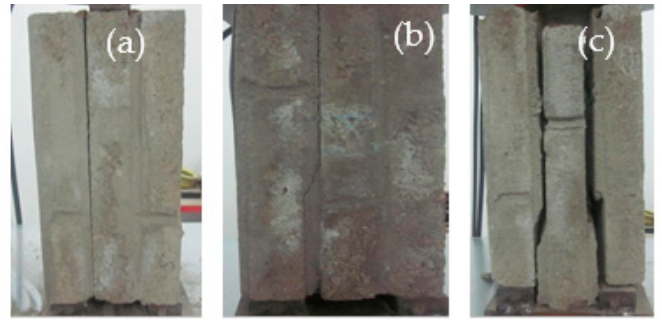
Figure 11. Failure pattern observed in shear test. ( a ) Single shear (0° angle). ( b ) Single shear (45° angle). ( c ) Double shear.